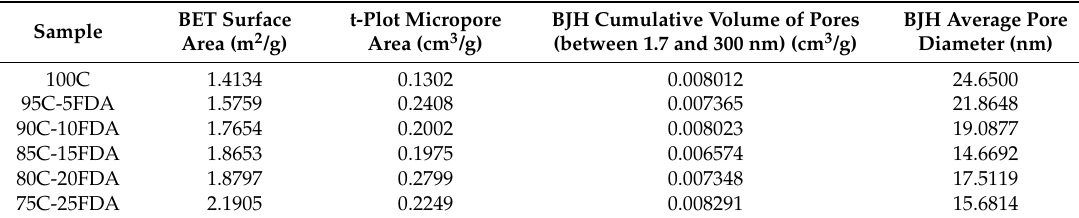
Table 4. BET surface, micropore area, BJH cumulative volume of pores, and BJH average pore diameter for clay-aluminum filter dust bricks.